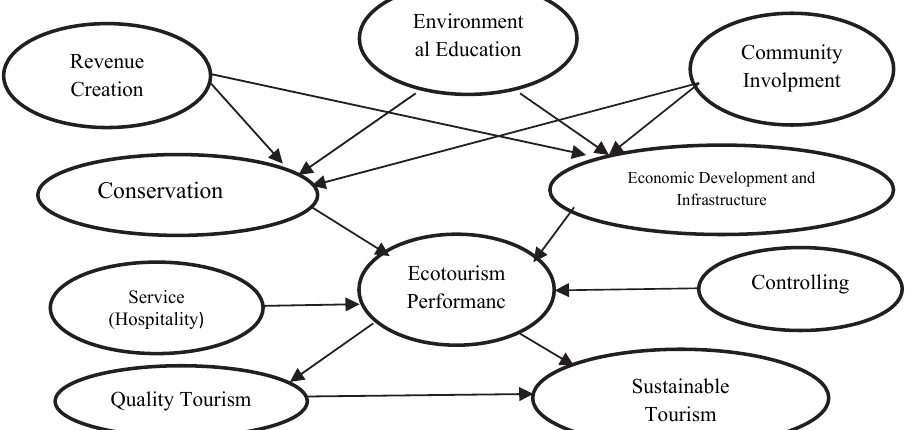
Fig. 2. Research Concept Framework, Policy Model Development and Enhancement of Tourism Performance, Quality Tourism Experience and Sustainable